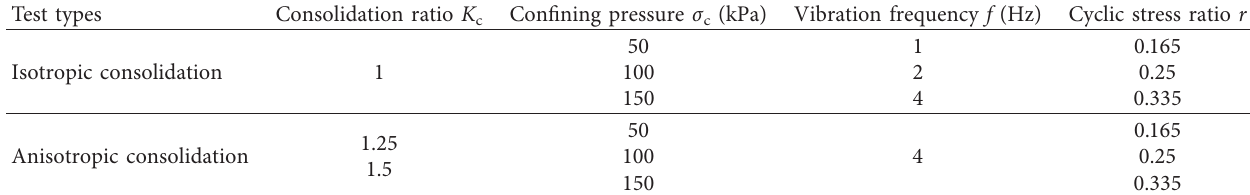
Table 2: Cyclic triaxial test scheme for saturated clay.